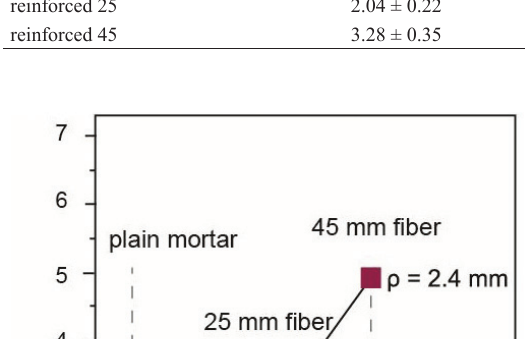
and impact energy for the M